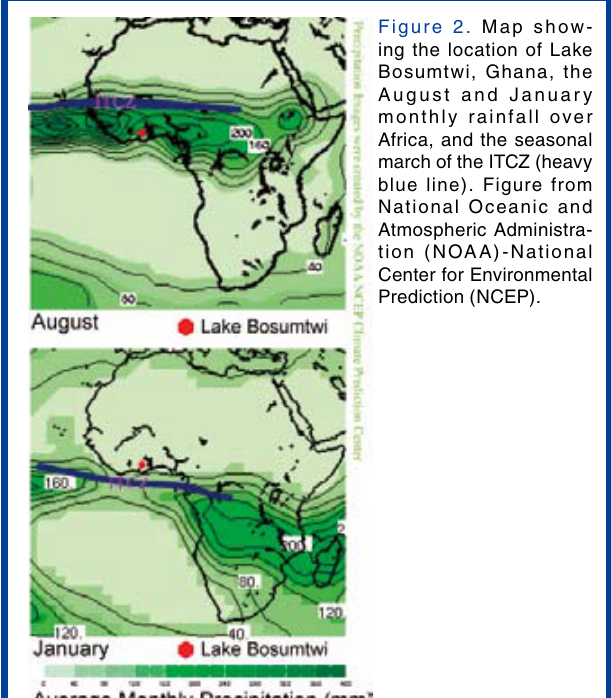
Figure 2. Map show- ing the location of Lake Bosumtwi, Ghana, the August and January monthly rainfall over Africa, and the seasonal march of the ITCZ (heavy blue line). Figure from National Oceanic and Atmospheric Administra- tion (NOAA)-National Center for Environmental Prediction (NCEP).